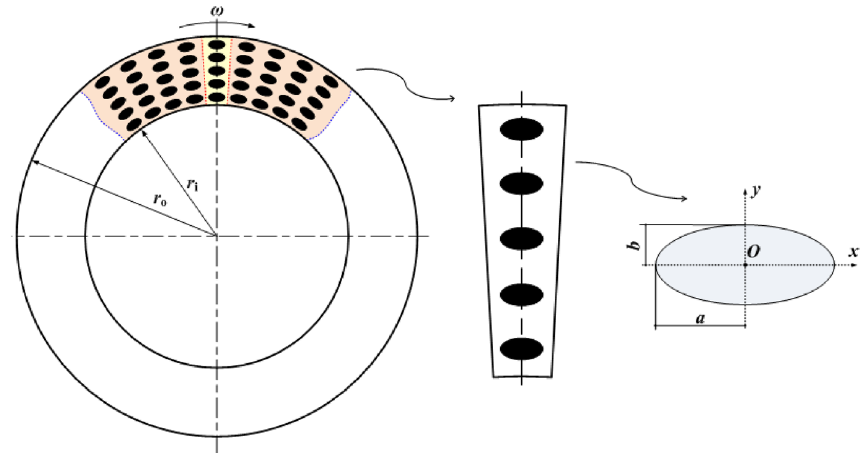
Figure 2. Geometry of textured surface with elliptical dimples.